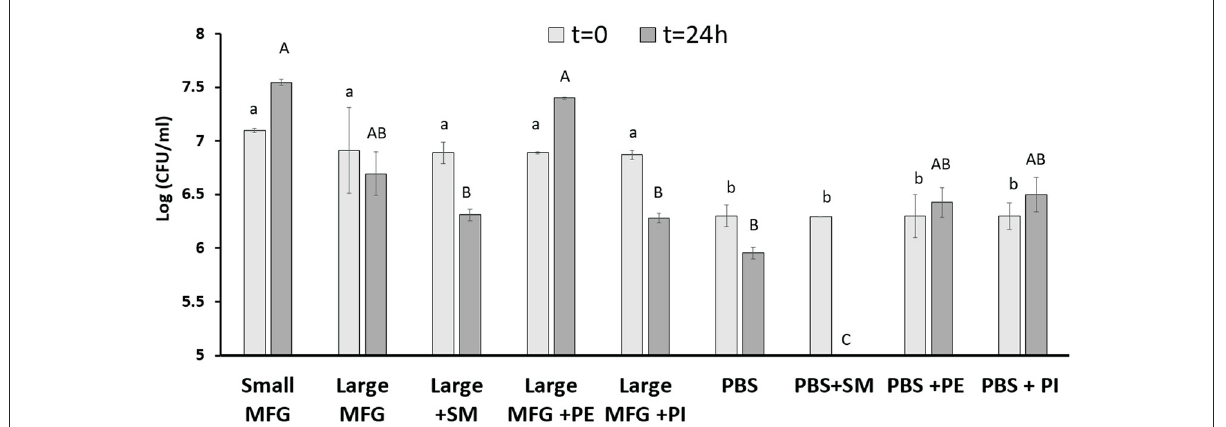
FIGURE6 Effect of MFG size and supplementation of polar lipids on B. subtilis growth. CFU counting of B. subtilis after 0 and 24h of incubation with small or large MFG, or large MFG supplemented with PE, PI or SM to match their concentrations in the small MFG fraction. Uppercase letters indicate significant differences between the treatment groups at 24h whereas lowercase letters indicate significant differences between the treatment groups at 0h ( P ≤ 0.05).